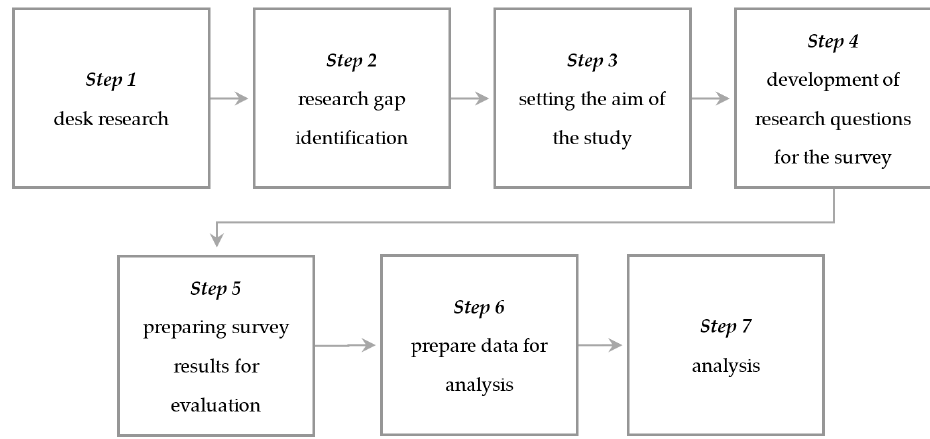
Figure 1. Methodological approach for this research.